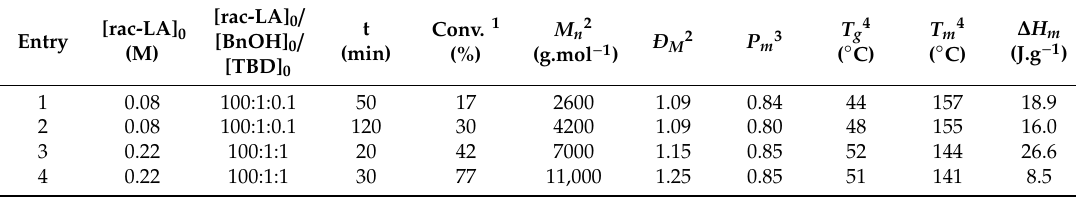
Table 1. ROP of rac -LA in toluene at − 75 ◦